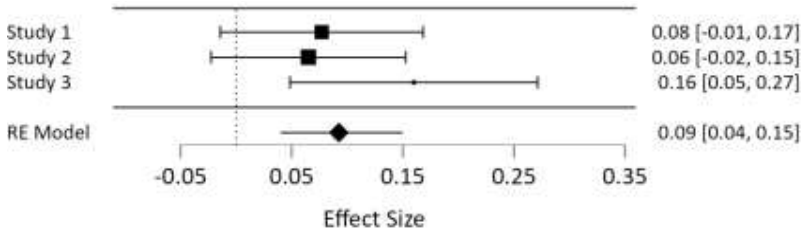
Figure 17. Forest plot of meta-analysis of Motivation for achievement and Conscientiousness Motivation for stimulation